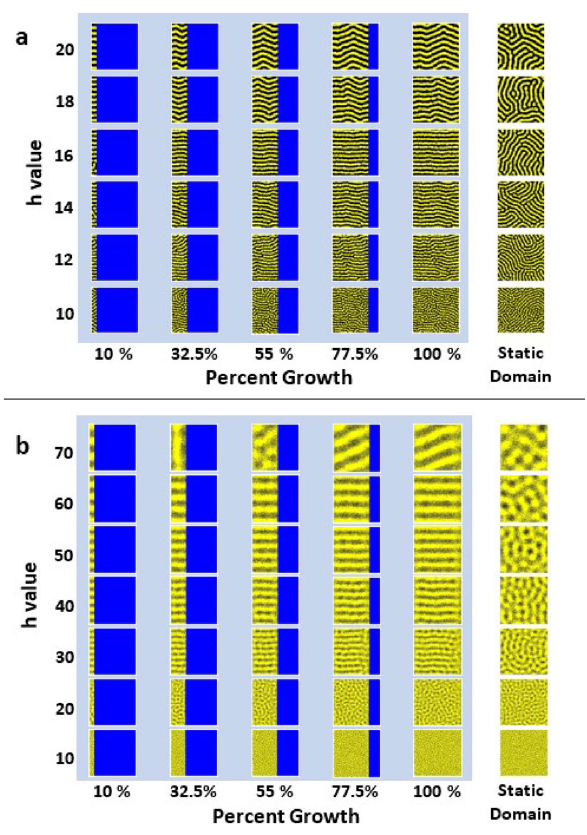
Figure 5. Turing pattern development during domain growth. For each h value, two simulations are presented: one on a growing domain (light blue backing) and one on a static domain (right column). For each simulation on a growing domain, images are shown of the developing pattern at 10%, 32.5%, 55%, 77.5%, and 100% of growth. The royal blue areas are the remaining area each simulation will grow into. All simulations are performed with periodic boundary conditions for the same simulation length. ( a ) Stochastic Monte Carlo simulations of the Promotion model on a growing domain. Each simulation begins as a 300 × 1 lattice, and grows to a final size of 300 × 300 . Each simulation is performed with b X = 1, s = 1, l X = 2.5, b M = d X = d M = 0 . ( b ) Stochastic Monte Carlo simulations of the Survival model on a growing domain. Each simulation begins as a 400 × 1 lattice, and grows to a final size of 400 × 400 . Each simulation is performed with b X = 1, s = 1, b M = 7, d M = 9, d X = d MX = 0